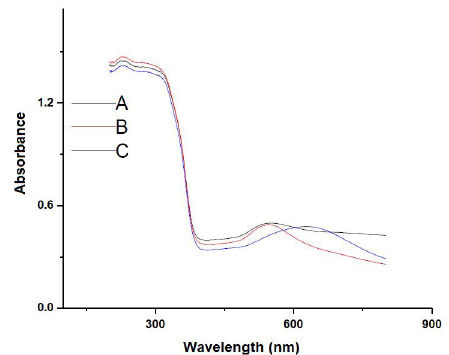
Figure 7. Films made from TiO without heating (left) and heating at 1,073 K (right).